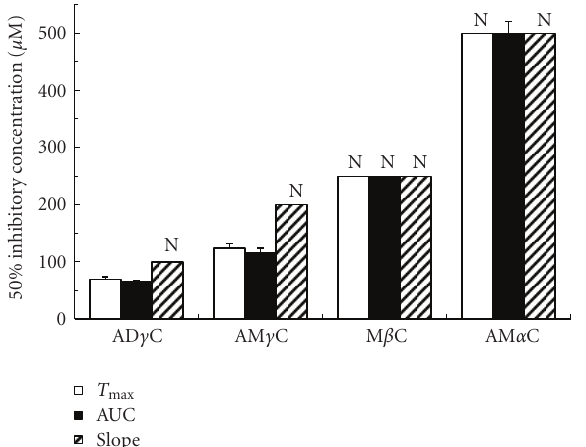
Figure 6: Concentrations of carbolines to produce 50% inhibition of the platelet aggregation responses ( T max , AUC, and slope) to ADP. N: Not inhibited by 50% at the indicated concentrations. Data are presented as mean ± SE ( n = 7).